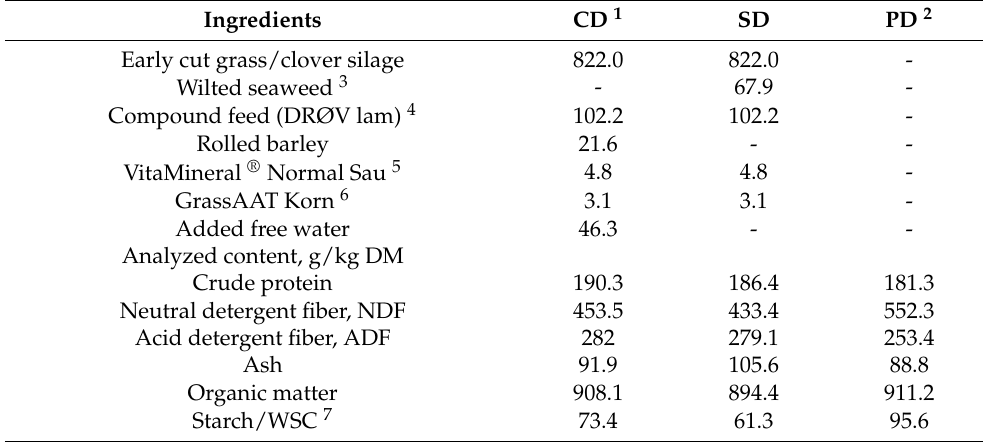
Table 1. Ingredient (g/kg) and chemical composition of three finishing lamb